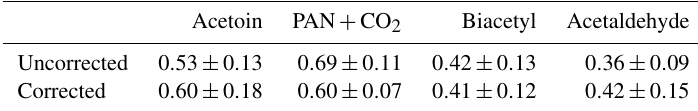
Table 4. Uncorrected and corrected molar yields of the 3M3P2 + OH system.